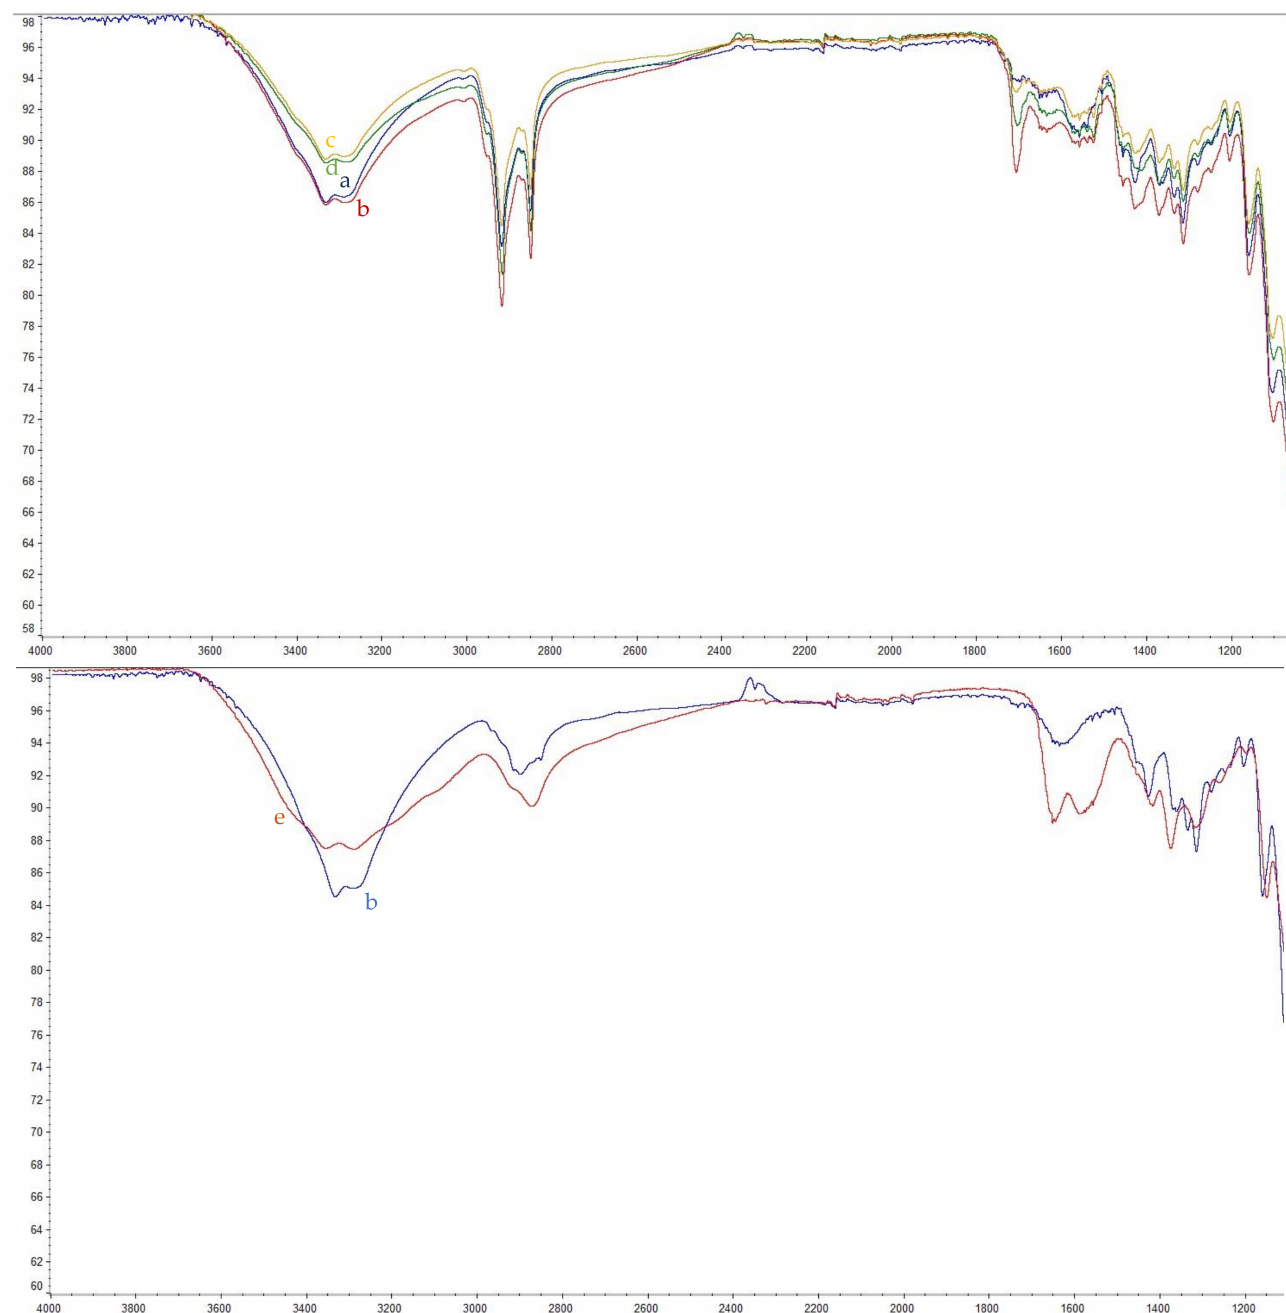
Figure 1. FTIR spectra: ( a ) composite 4, navy blue; ( b ) composite 2, red; ( c ) composite 3, yellow; ( d ) composite 1, green; ( e ) chitosan, orange; ( f ) cotton textile,